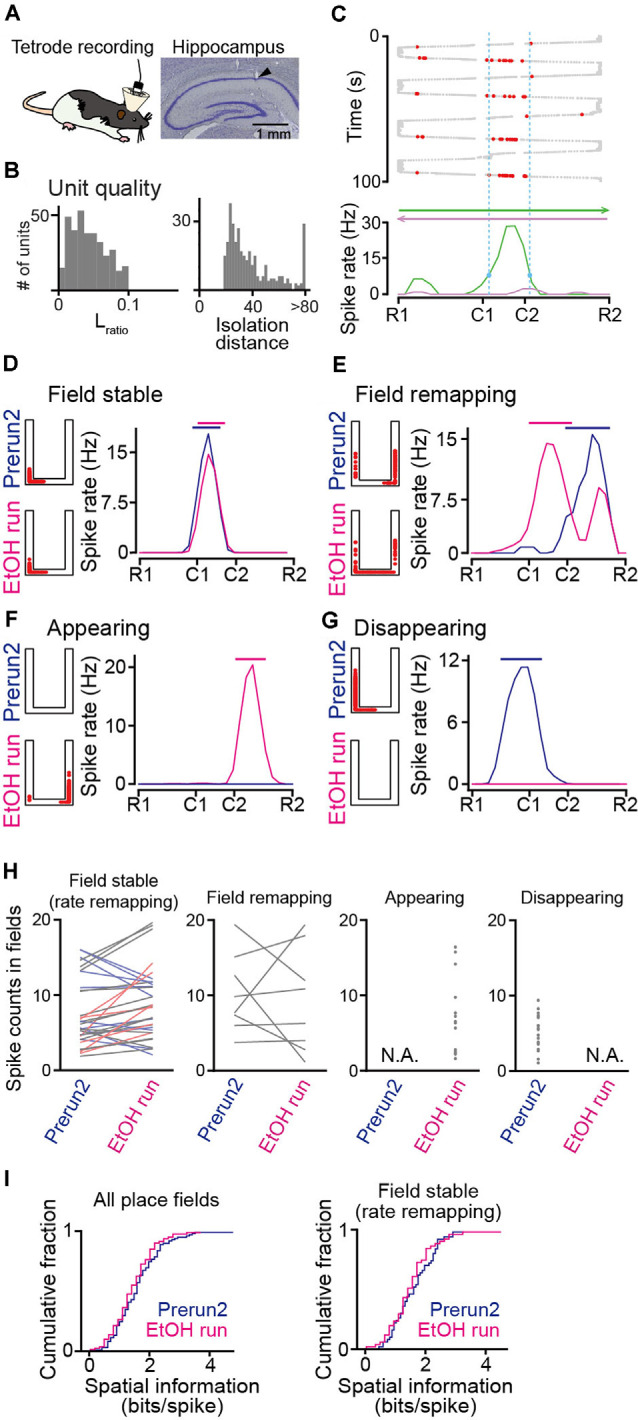
Recording of place cell firing in ethanol-injected rats. (A; Left) Tetrode recordings were performed from the dorsal hippocampal CA1 area in freely moving rats. (Right) Histological confirmation of a recording site in the CA1 cell layer in a cresyl-stained section. The arrowhead indicates the track of the electrode. (B) The distributions of Lratio and isolation distance for individual neuronal units, identified by multiunit spike sorting. (C) The spatial firing of a representative place cell. (Top) Spike locations are indicated by the red dots superimposed on the animal’s trajectory (thick and thin gray dots). (Bottom) Spatial firing-rate distributions constructed from the firing locations above separately analyzed for each running direction. The range of the place field is indicated by the dashed vertical cyan lines. (D–G) Representative place cells showing typical firing characteristics before (Prerun2) and after (EtOH run) administration of ethanol (D, field stable; E, field remapping; F, appearing; and G, disappearing). In each graph, the left panel shows the spike locations as red dots superimposed on the maze structure, and the right panel shows the spatial firing-rate distributions (blue, Prerun2; magenta, EtOH run). The bars above indicate the areas of the place fields. (H) Ethanol-induced changes in spike counts per lap within place fields, separately plotted for field stable with rate remapping, field remapping, appearing, and disappearing fields (n = 50, 8, 19, and 43 fields). Each line and each dot represent an individual place cell. Stable place fields were further classified into no rate remapping (gray, n = 25 fields) or rate remapping (increase: light red, n = 6 fields; decrease: light blue, n = 19 fields). Sessions with no place fields identified were represented as N.A. (I) Cumulative distributions of spatial information of all place fields identified (left) and stable fields (right). P > 0.05, Kolmogorov–Smirnov test.